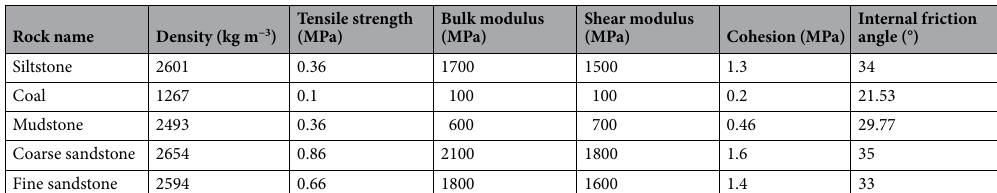
Table 3. Physical and mechanical parameters of the coal seam, roof and floor in the working